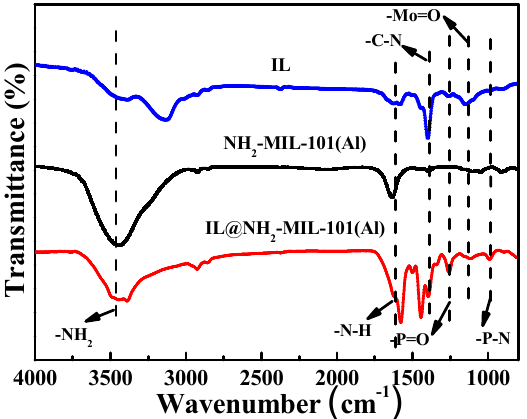
Figure 2. FT-IR patterns of IL, NH 2 -MIL-101(Al) and IL@NH 2 -MIL-101(Al).